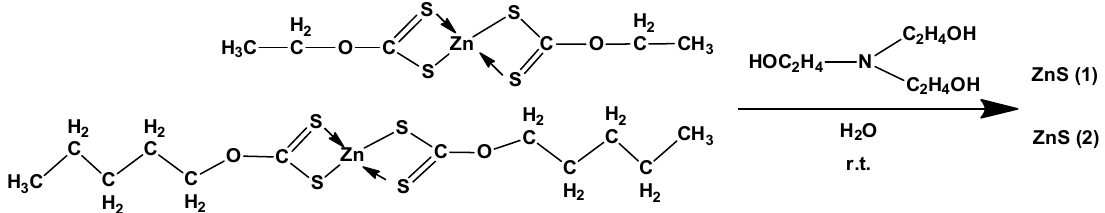
Scheme 1. Reaction conditions for preparation of samples ZnS(1) and ZnS(2).